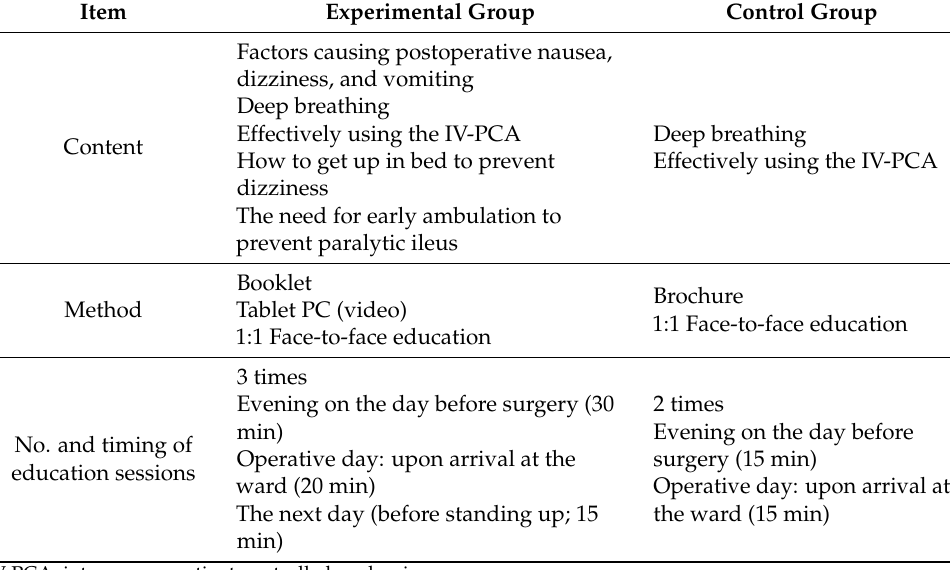
Table 1. Educational content for the experimental group and control